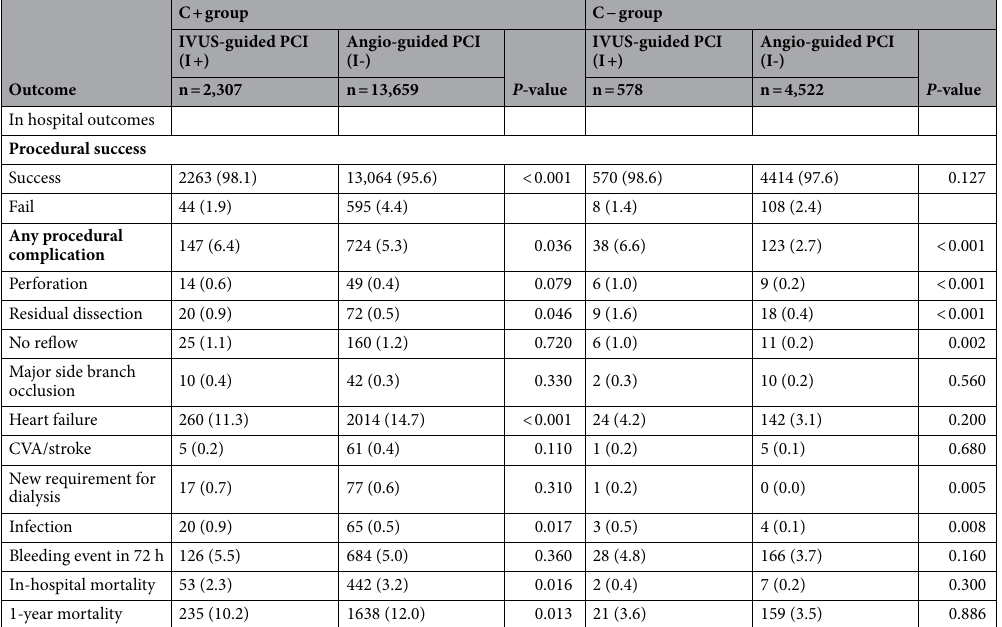
Table 3. Procedural success and complication rates. Values are expressed as n (%) or mean ± SD. Abbreviations : C + , met criteria; C−, unmet criteria; CVA, cerebrovascular accident; IVUS,